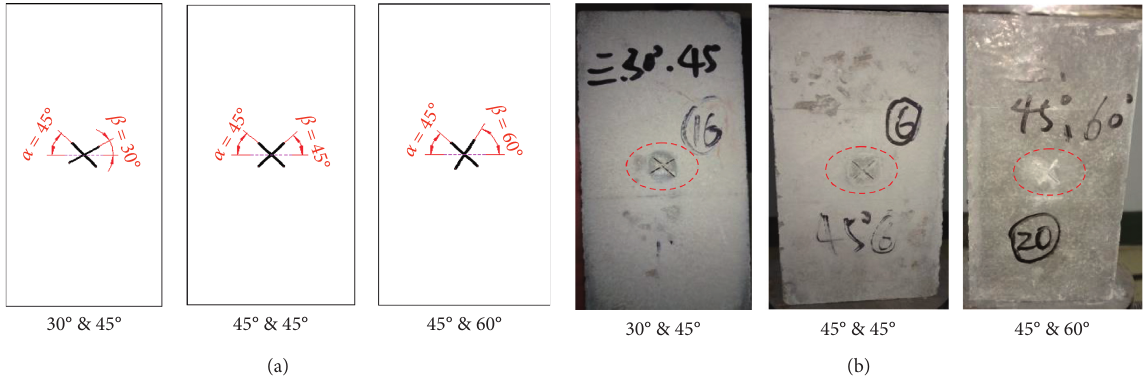
Figure 3: Parts of rock-like specimens prepared with (a) sketchy map of “X” fracture specimen with different angles and (b) parts of single “X” fracture rock-like specimen prepared.